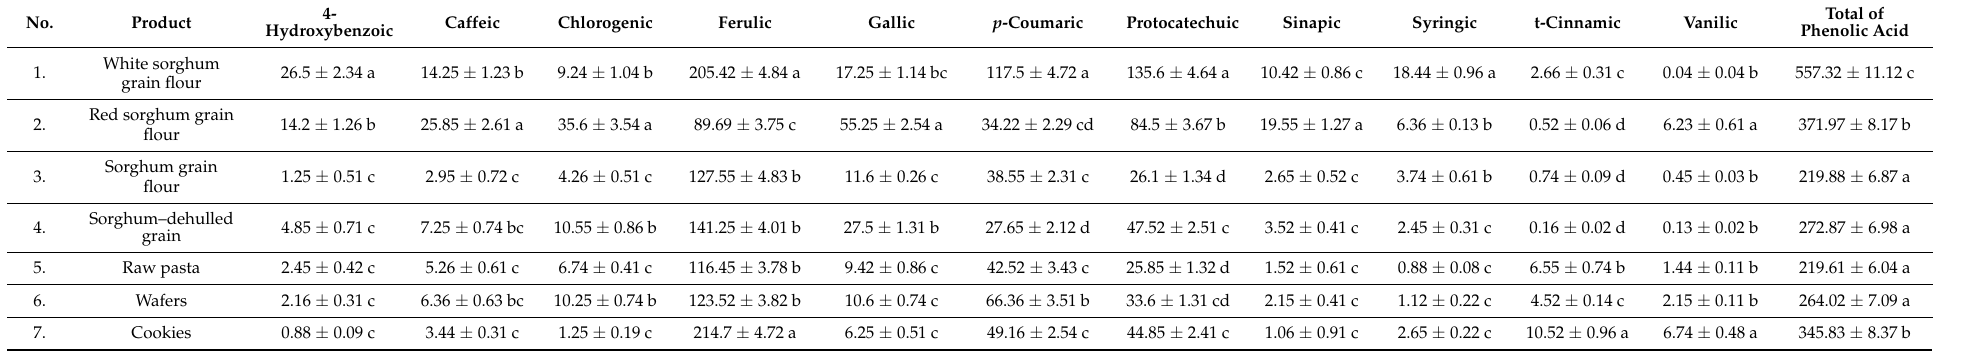
Table 4. Content of selected phenolic acids (mg/kg) in food products.